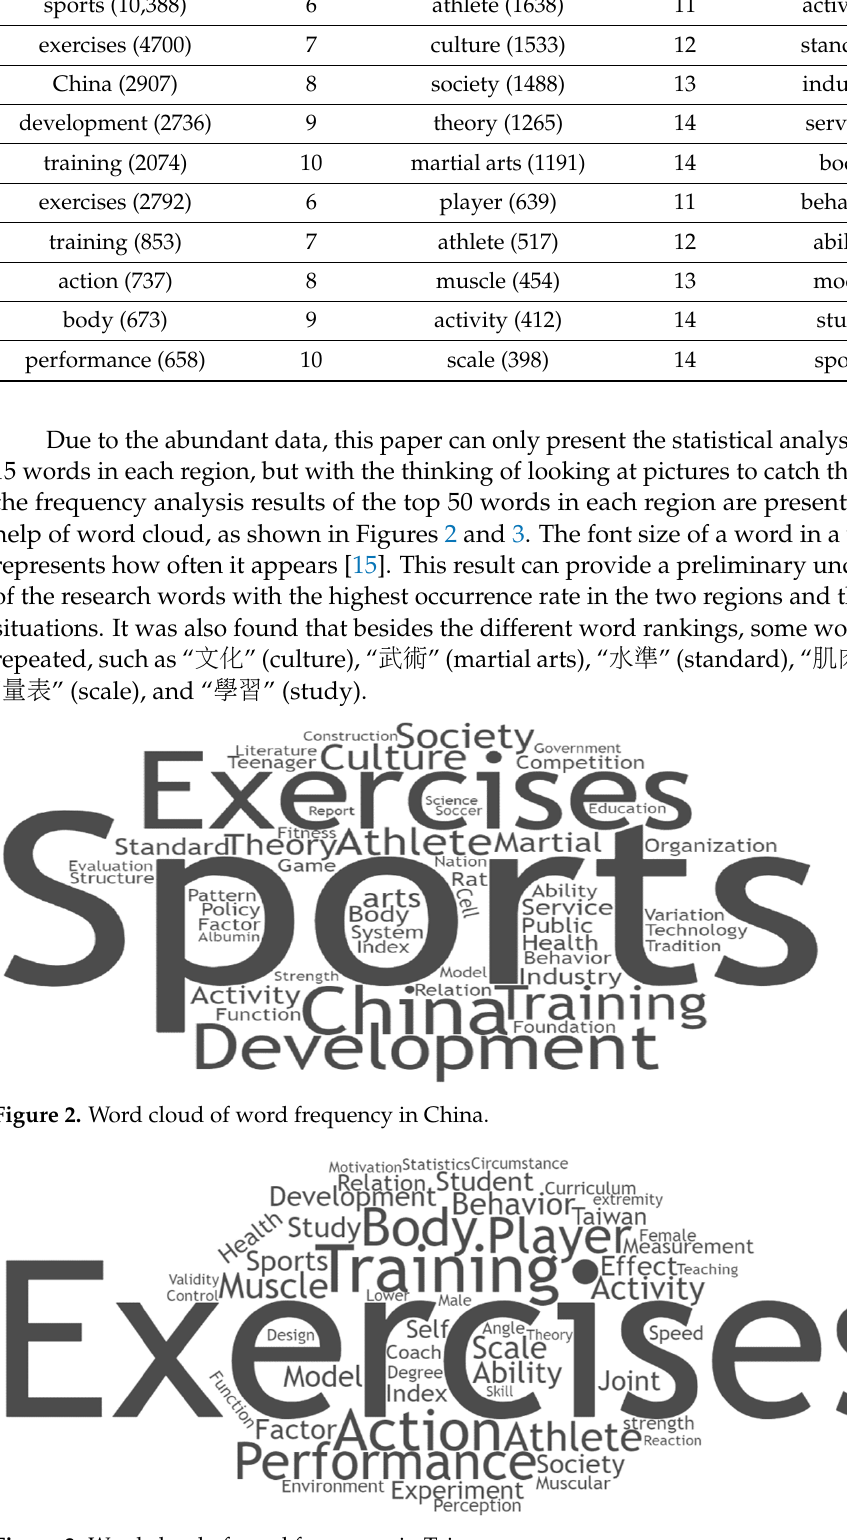
Figure 3. Word cloud of word frequency in Taiwan.